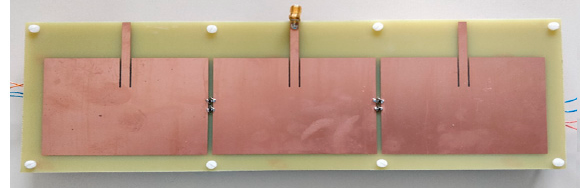
Figure 18. Top view of the P-ESPAR antenna.